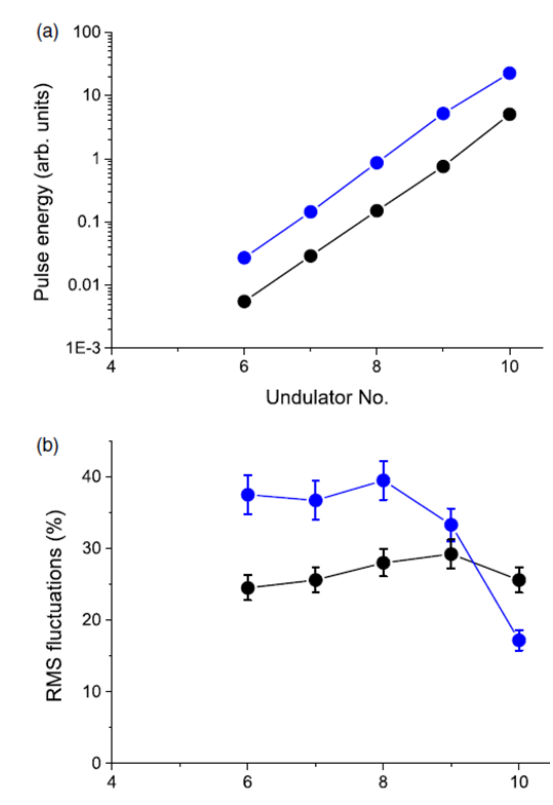
Figure 7. Growth of pulse energy ( a ) and fluctuations ( b ) along the undulator for SASE (black) and HLSS (blue). In the HLSS experiment the first four undulators were set to 33 nm and the next six undulators to 11 nm, while in the SASE case all ten undulators modules were set to 11